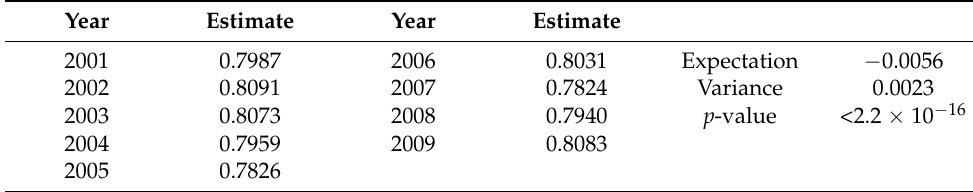
Table 4. Moran’s I statistics for the logs of NO x .